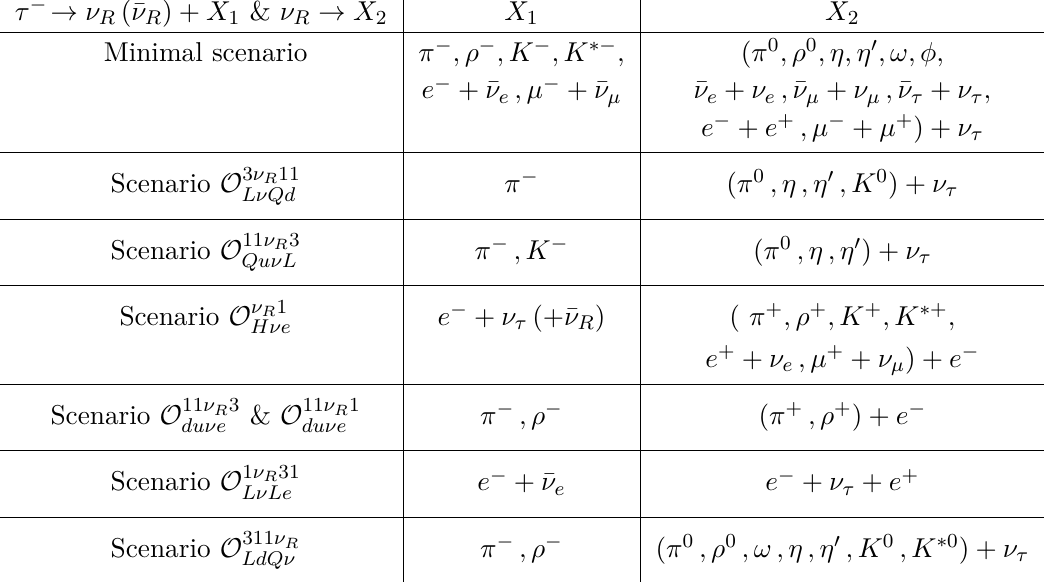
Table 2 . All possible production, X 1 , and decay, X 2 , modes of a sterile neutrino ν R at Belle II . The charge conjugate modes are